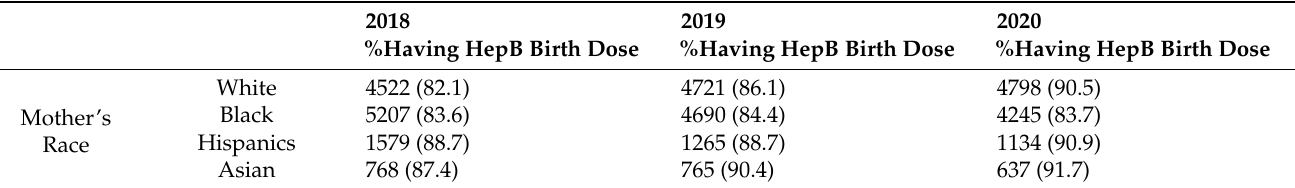
Figure 1. Trend of HBV birth dose rates in Washington metropolitan region, 2018–2020. Note p < 0.001. Table 1. HepB birth dose vaccination rates by race/ethnicity, 2018–2020.